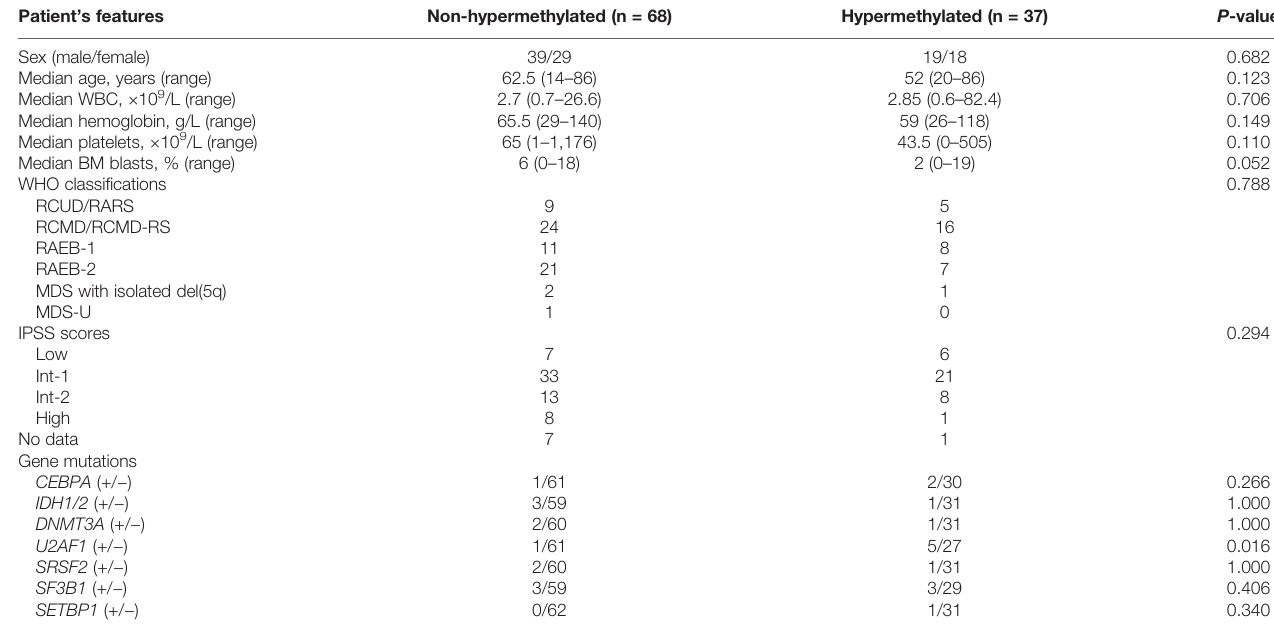
TABLE 1 | Comparison of clinical and laboratory features between LEP hypermethylated and non-hypermethylated MDS patients. Patient ’ s